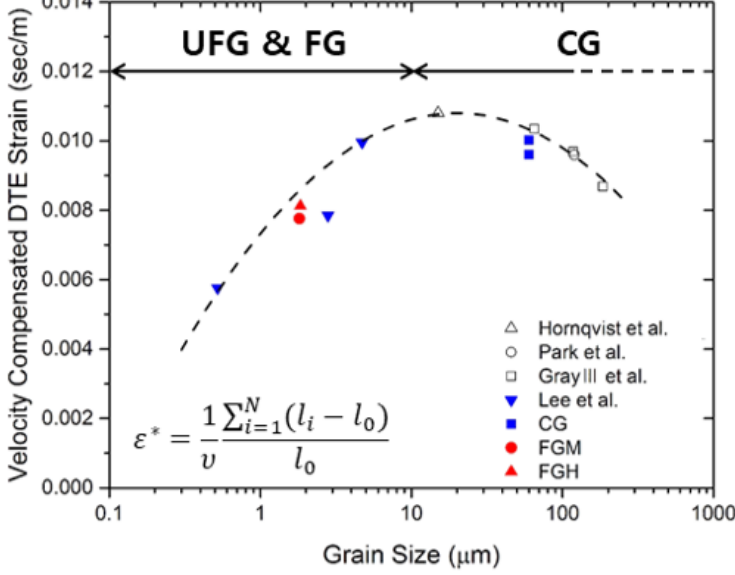
Figure 9. Velocity-compensated DTE strain of Cu as a function of initial grain size. The symbol of “*” means the velocity compensated DTE strain as represented in Equation (2) ( △ Hörnqvist et al. [6], ○ Park et al. [5], □ Gray et al. [4], ▼ Lee et al. [9]).